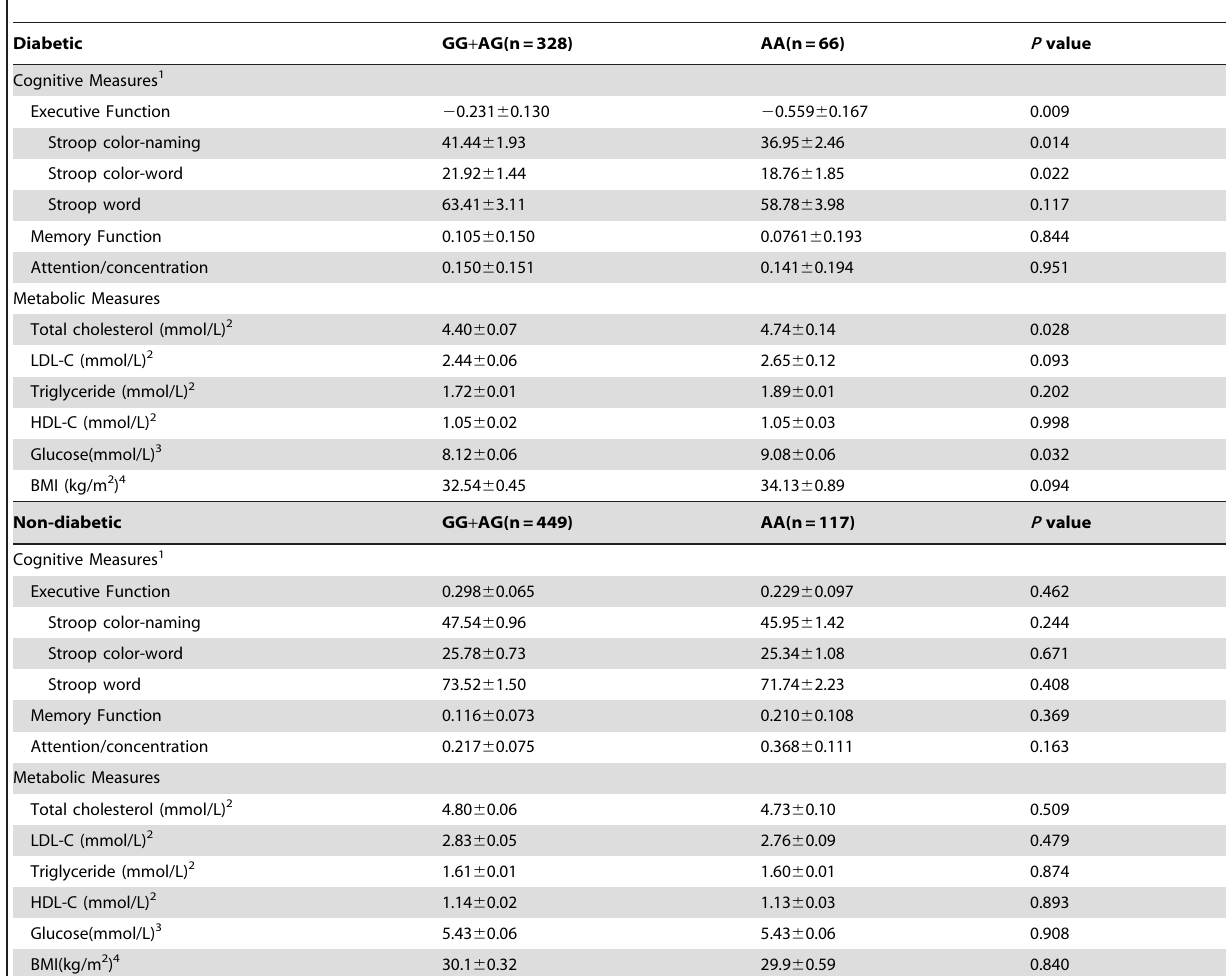
Table 2. Cognitive and metabolic measures for APOC3 m482 in Caribbean